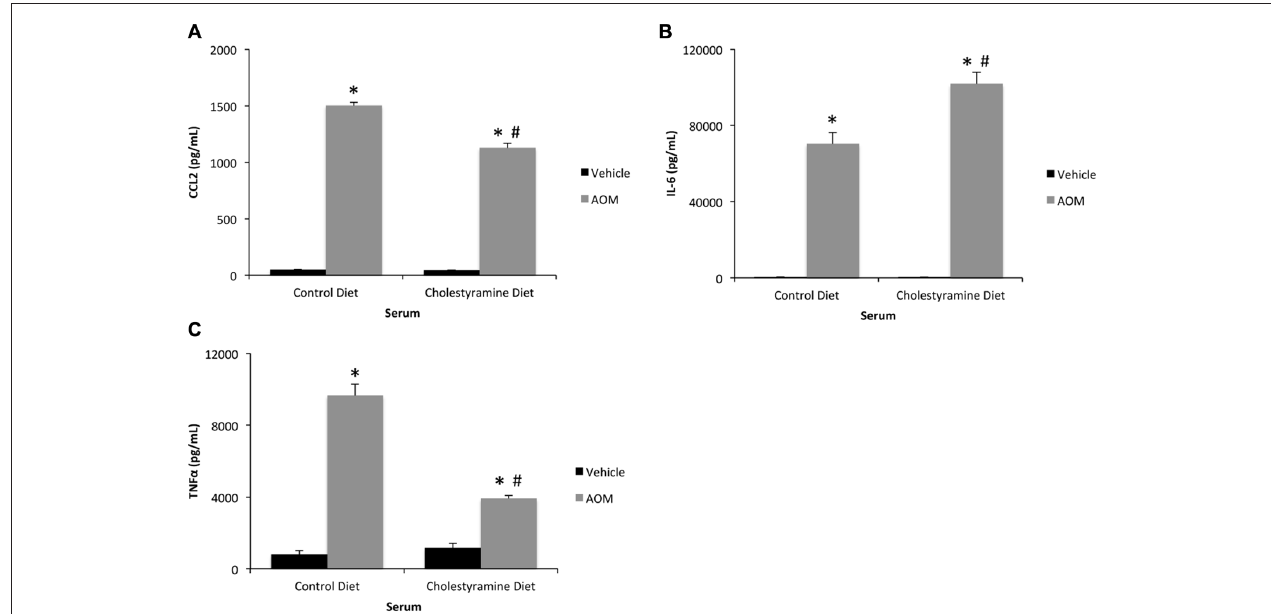
FIGURE 2 | Systemic inflammation may be modulated by cholestyramine supplementation. (A) Serum consequence of chemokine ligand 2 (CCL2) concentrations measured by ELISA assay in control diet or cholestyramine diet-fed mice administered vehicle or AOM. (B) Interleukin-6 (IL-6) concentration in the serum of control diet or cholestyramine diet-fed mice injected with vehicle or AOM. (C) Serum tumor necrosis factor alpha (TNF α ) concentrations measured by ELISA assay in control diet or cholestyramine diet-fed mice administered vehicle or AOM. ∗ p < 0.05 compared to control diet vehicle-treated mice, # p < 0.05 compared to control diet AOM-treated mice. n = 3 or greater for all